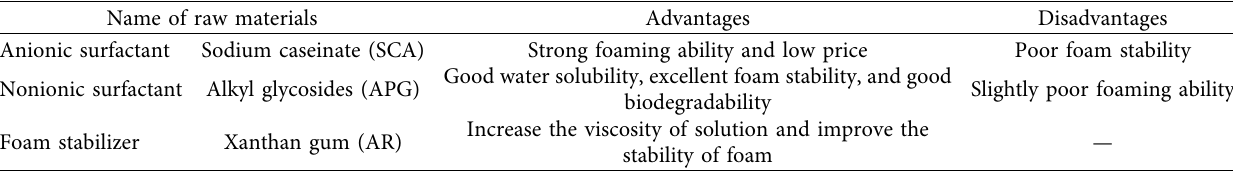
Table 1: Composite foaming agent raw materials.